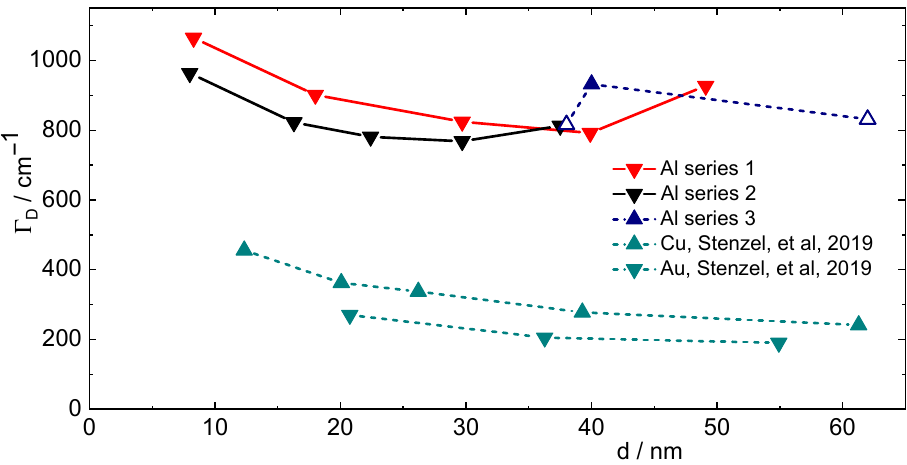
Figure 9. Dependence of the Drude damping parameter on the thickness [21].